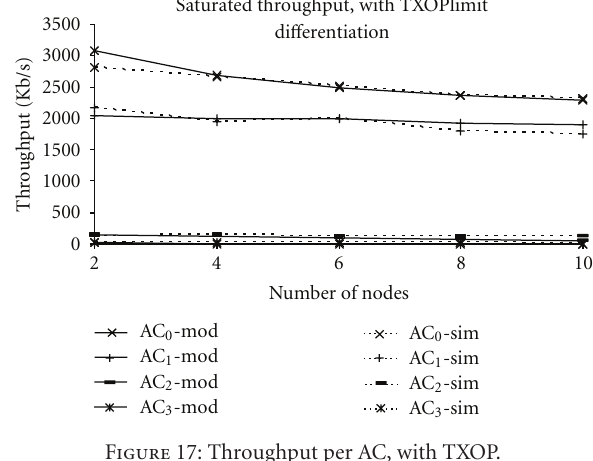
Figure 19: Mean access delay per AC, with